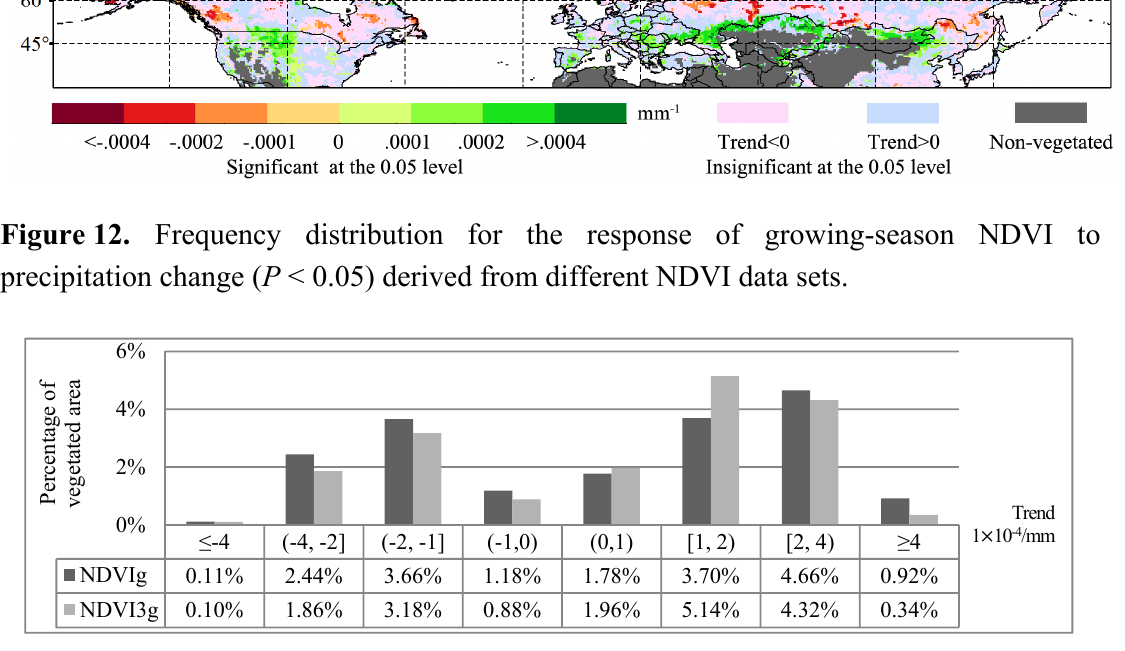
Figure 13. Differences between NDVI3g and NDVIg in the response of growing-season NDVI to precipitation change during